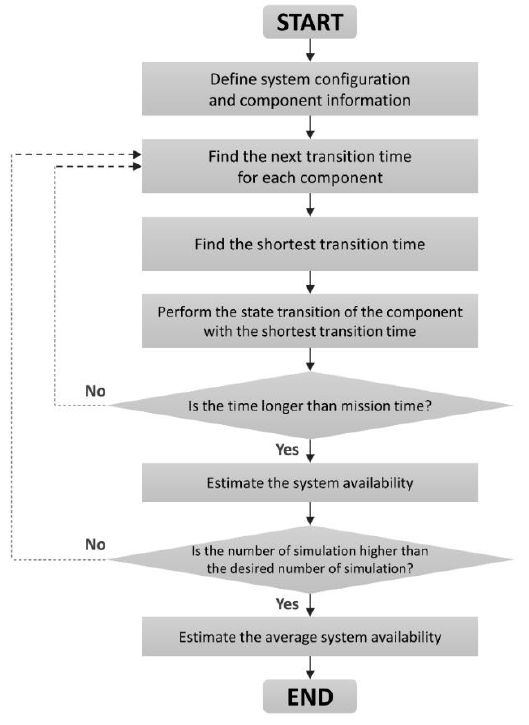
Figure 11. Procedure for availability estimation using Monte Carlo simulation [21].